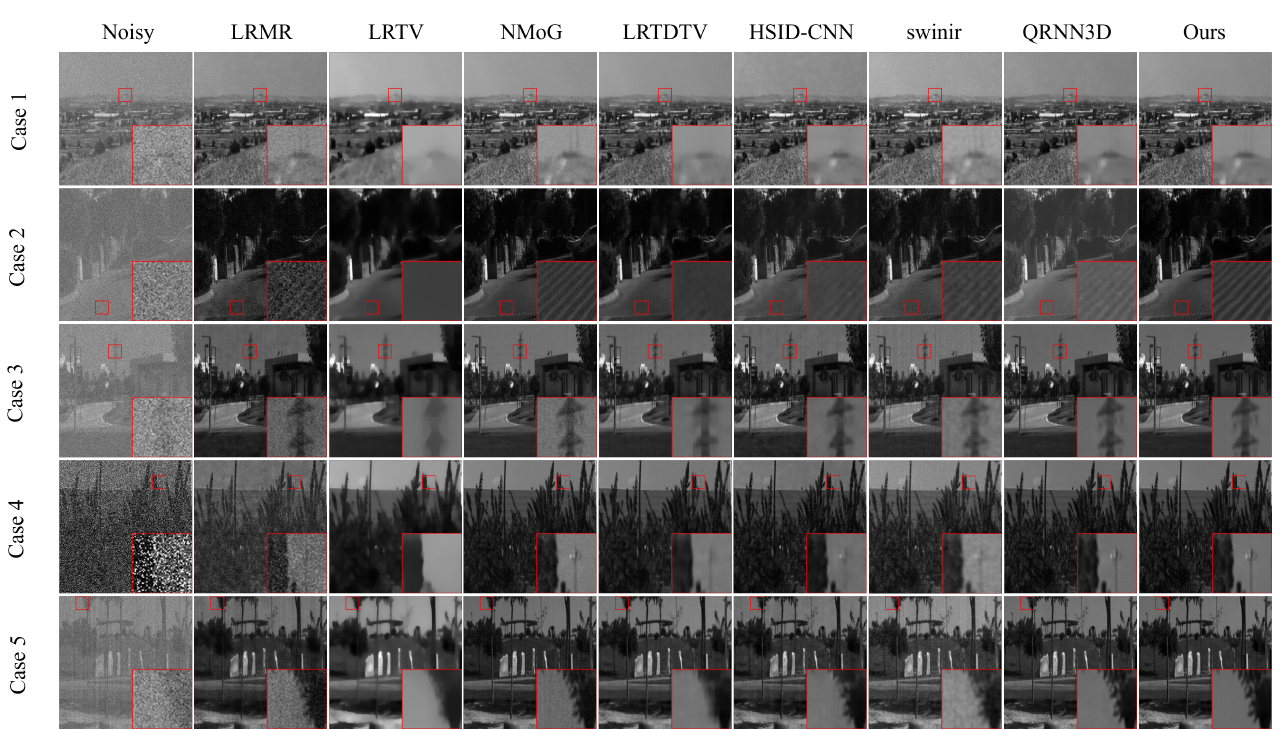
Figure 5. Visual comparison of the denoised image for all the five cases of the ICVL